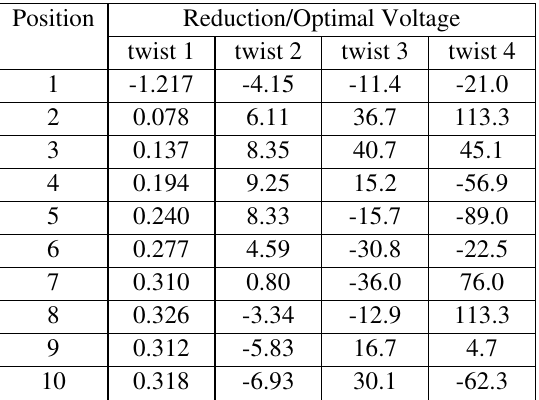
Table 4. Ratio Reduction/Optimal Voltage for the first four-